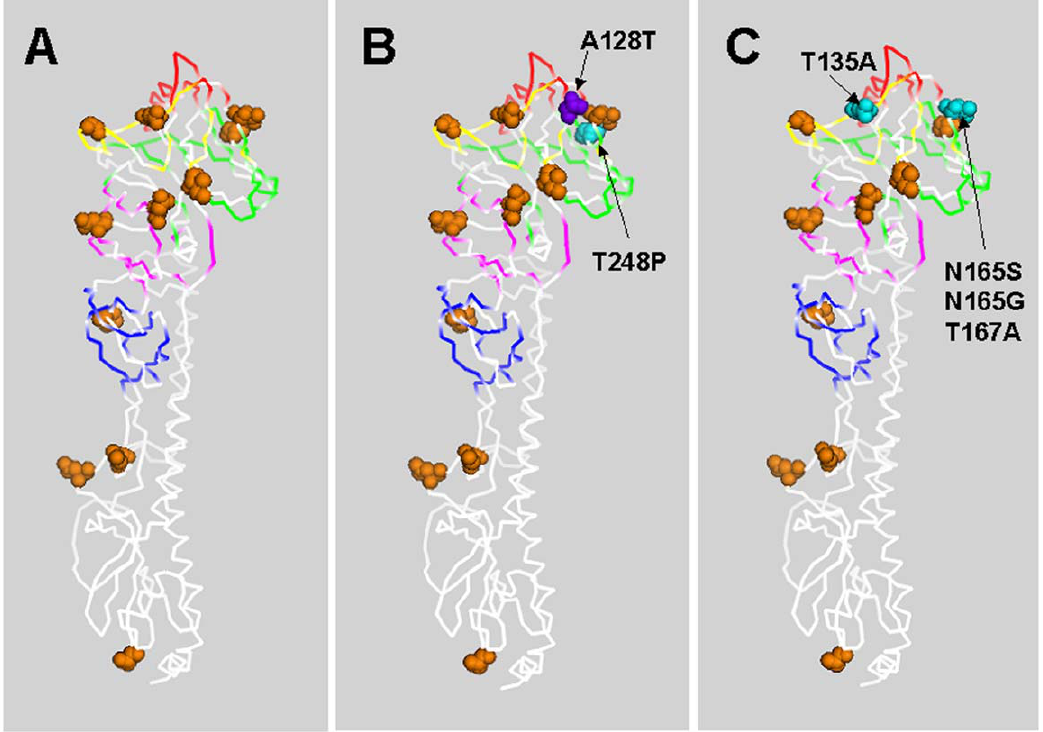
Figure 4. Analysis of Glycosylations. Space-filled model of HA ectodomain from related H3N2 strain X31 drawn with PyMOL using 2VIR.pdb [19]. Panel A shows the H3N2 glycosylation sites of the wild type Wyoming/2003, Panel B shows glycosylation site changes in the naı¨ve Guinea pigs, and Panel C shows glycosylation site changes in the immunized Guinea pigs. Epitopes A, B, C, D, E are shown colorized in yellow, red, blue, green and pink, respectively. Receptor binding site is shown as mesh. Residues at which glycosylation sites were either lost during the evolution of the virus in Guinea pigs are shown in cyan, or sites that were added in purple. doi:10.1371/journal.pone.0020130.g004 PLoS ONE |